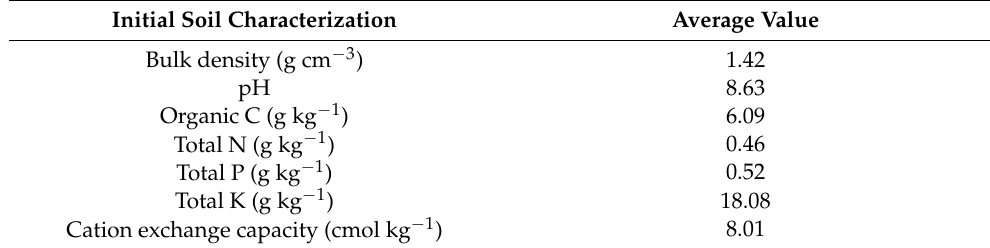
Table 1. Initial soil characterization of the site.